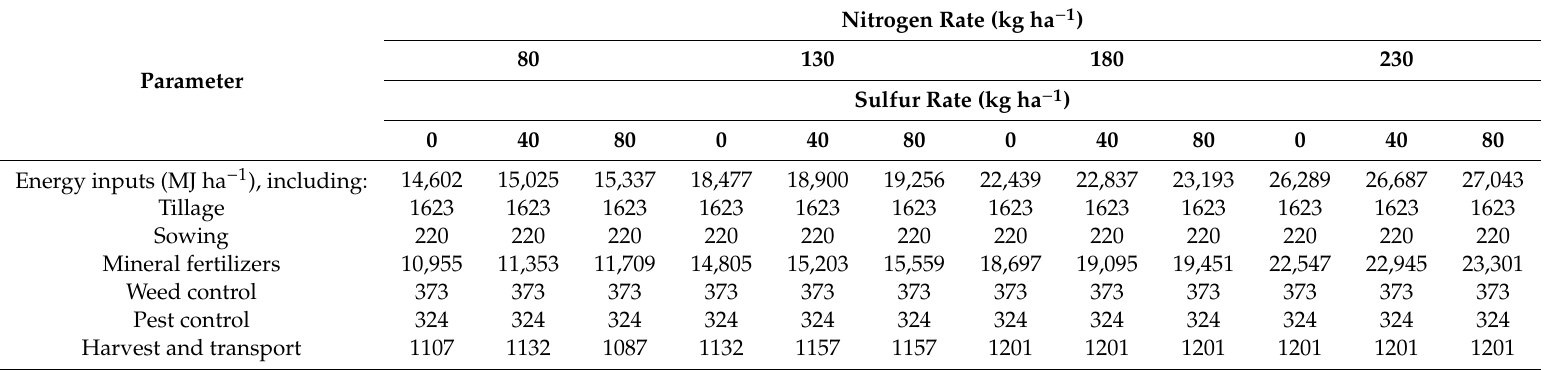
Harvest and transport Table 12. Energy inputs in the production of the long-stem hybrid cultivar of winter oilseed rape (cv. Artoga), across years.